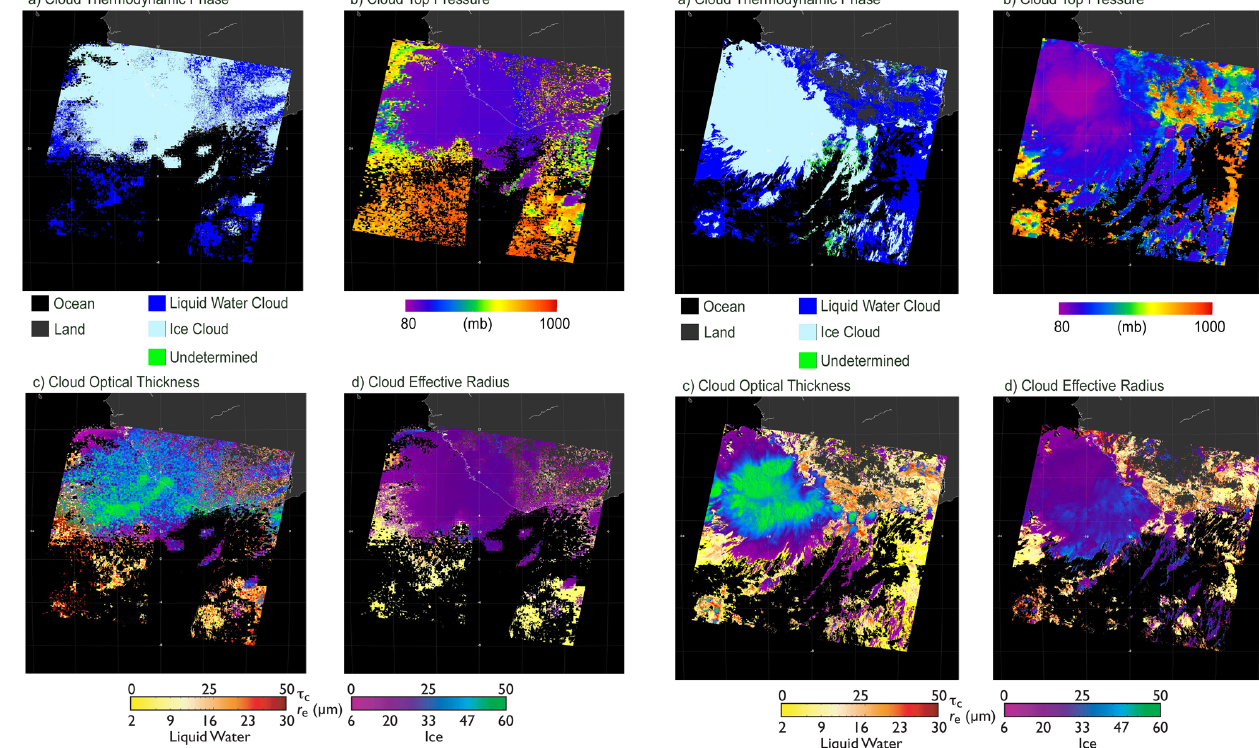
Fig. 7. Actual cloud retrieval for Terra MODIS 2013 day 151 at 11:15UTC. (a) is cloud thermodynamic phase, (b) cloud top pres- sure, (c) cloud optical thickness and (d) cloud effective radius from the 0.86–2.1µm band combination.